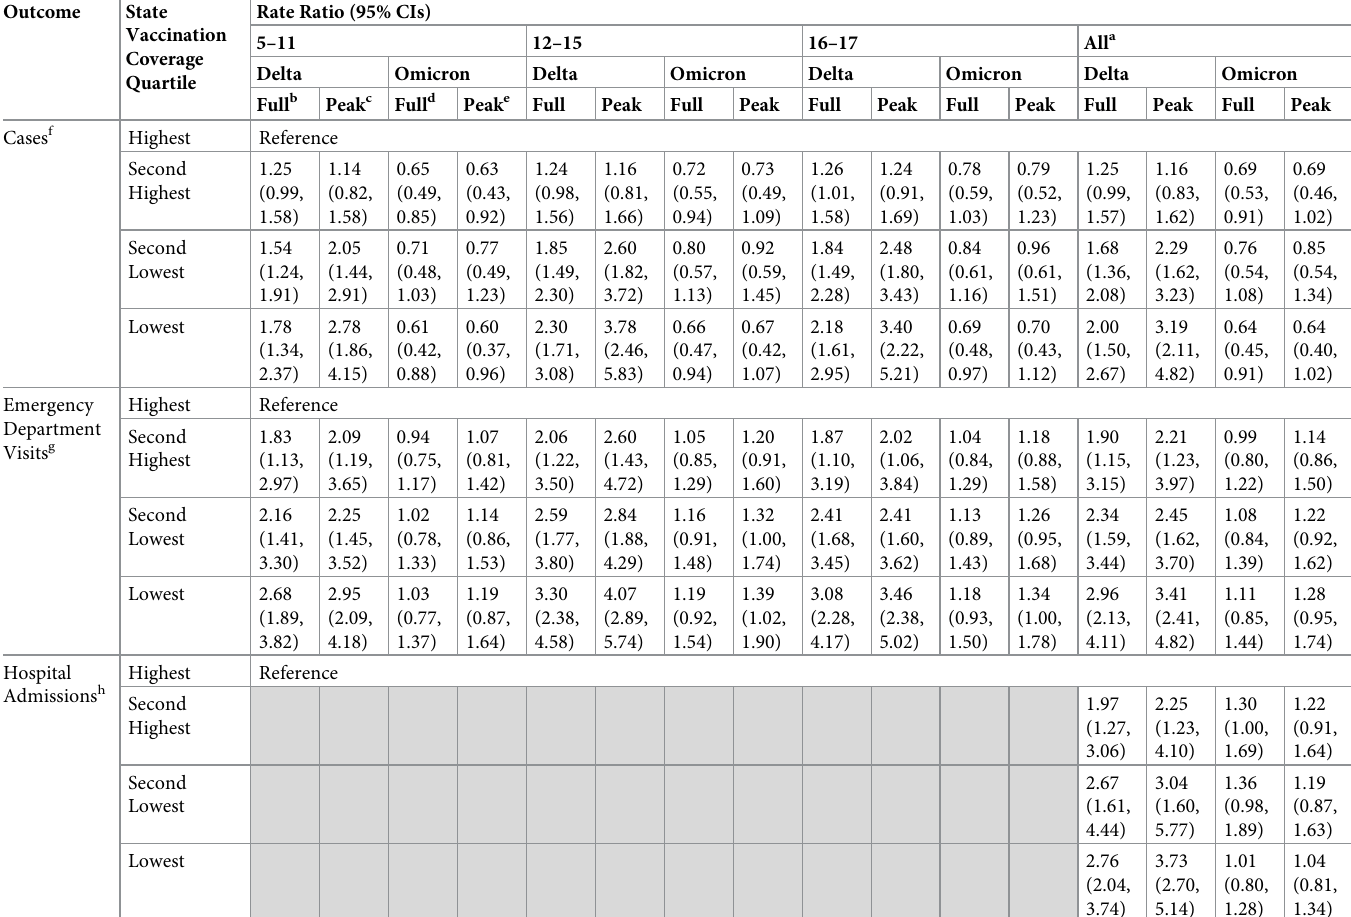
Table 2. Rate ratios among children aged 5–17 years by outcome comparing COVID-19 pediatric vaccination coverage quartiles of states to states in the highest vaccination coverage quartile during Delta and Omicron predominant periods–by age group and overall. Outcome State